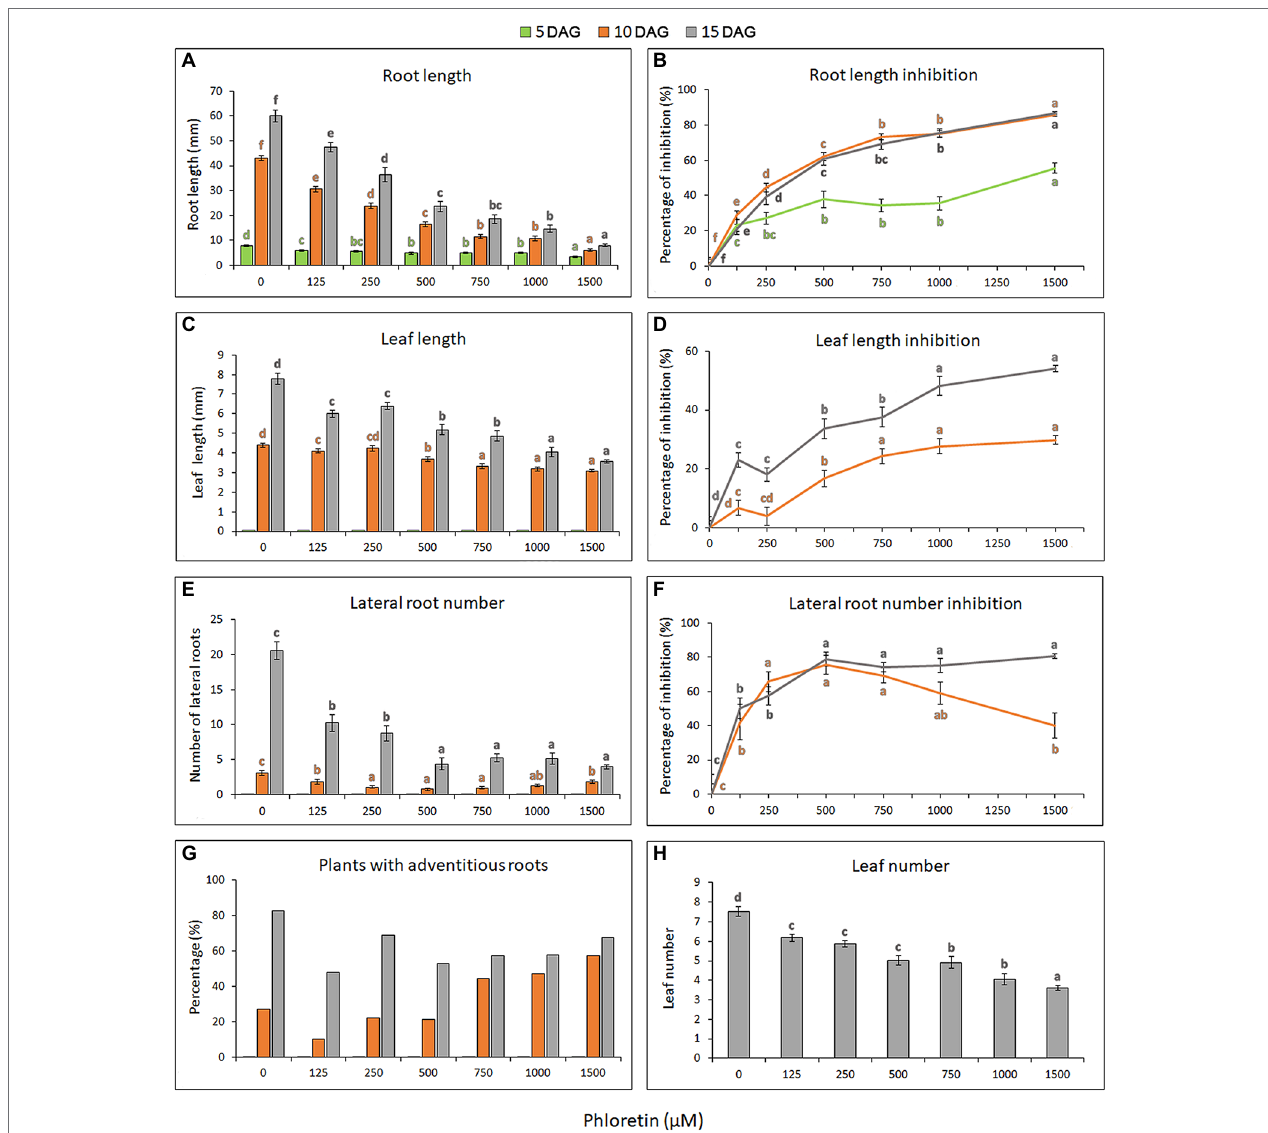
FIGURE 3 | Dose-dependent effects of phloretin on Arabidopsis growth. Seeds were grown vertically on medium supplemented with phloretin in increasing concentrations (0, 125, 250, 500, 750, 1,000 and 1,500 μ M). (A) Primary root length, (B) primary root length inhibition, (C) true leaf length, (D) true leaf length inhibition, (E) lateral root number, (F) lateral root number inhibition and (G) percentage of plants developing at least one adventitious root presented at 5, 10 and 15 d after germination (DAG); (H) the true leaf number presented at 15 DAG. Values represent means ± SE of 30 explants per each treatment repeated three times ( n = 90). Values followed by different letters of the same color are significantly different at p < 0.05 per Fisher’s least significant difference (LSD)